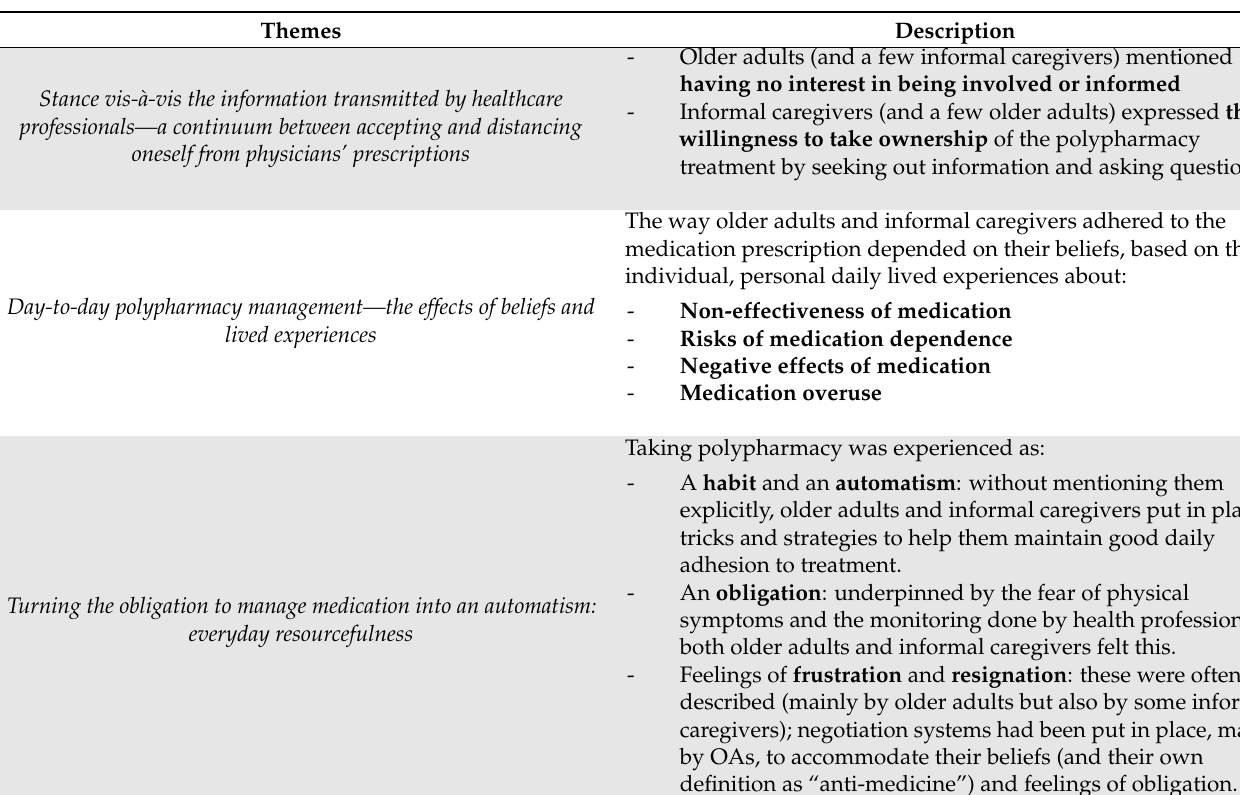
Table 3. Summary of the main interview